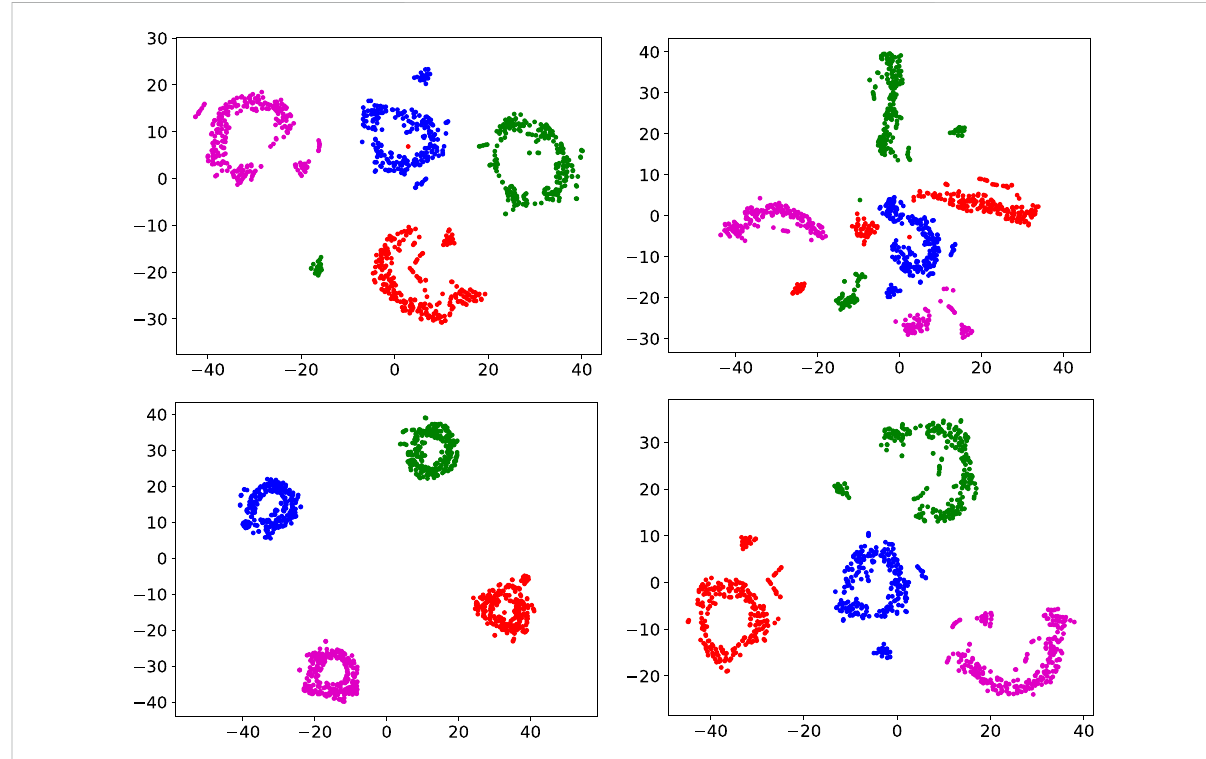
FIGURE 15 Comparison of the t-SNE analysis between MELA and MOE with and without the proposed diversity enforcement, using 4 experts for locomotion (blue and purple) and gait recovery (red and green). Top left: MELA without diversity enforcement, top right: MOE without diversity enforcement, bottom left: MELA with diversity enforcement, bottom right: MOE with diversity